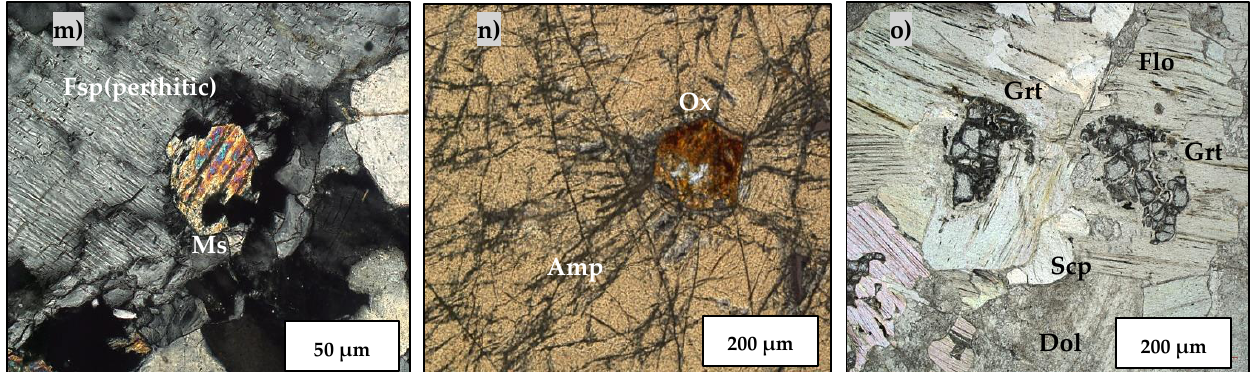
Figure 4. Optical microscope images of southwestern Oaxacan Complex garnets: ( a ) Suballotriomorphic Grt in crossed nicols from Qz-Fsp paragneiss (LCOx77); ( b ) Suballotriomorphic Grt blastopoikilitic of Qz Grt aggregate in crossed nicols from basic orthogneiss (LCOx83b); ( c ) Suballotriomorphic Grt aggregates in crossed nicols from basic orthogneiss (LCOx61); ( d ) Suballotriomorphic Grt with interstitial tendency in crossed nicols from intermediate orthogneiss (LCOx98); ( e ) Suballotriomorphic Grt blastopoikilitic of Qz, Pl, Amp, and Ap in crossed nicols from intermediate orthogneiss (LCOx64); ( f ) Suballotriomorphic Grt blastopoikilitic of Qz in crossed nicols from Qz-Fsp paragneiss (LCOx10); ( g ) Suballotriomorphic Grt blastopoikilitic of Opx, Pl, and Amp in crossed nicols from intermediate orthogneiss (LCOx59b); ( h ) Subidiomorphic Grt with partial Chl rims in plane polarized light from semipelitic granulite (LCOx26); ( i ) Boudins of Grt, Pl, and Qz in plane polarized light from Qz-Fsp paragneiss (LCOx9a); ( j ) Incipient Boudins of Grt surrounded by Ser, Pl, and Qz in crossed nicols from basic orthogneiss (LCOx49); ( k ) Amp formed at the expense of Grt in crossed nicols from intermediate orthogneiss (LCOx59b); ( l ) Bi formed at the expense of Grt in plane polarized light from basic orthogneiss (LCOx101); ( m ) Grt mold filled by Ms in crossed nicols from Qz-Fsp paragneiss (LCOx83a); ( n ) Grt mold filled by oxides in plane polarized light from amphibolite (LCOx73); ( o ) Consumed Grt rims in plane polarized light from anatectic marble (LCOx76).